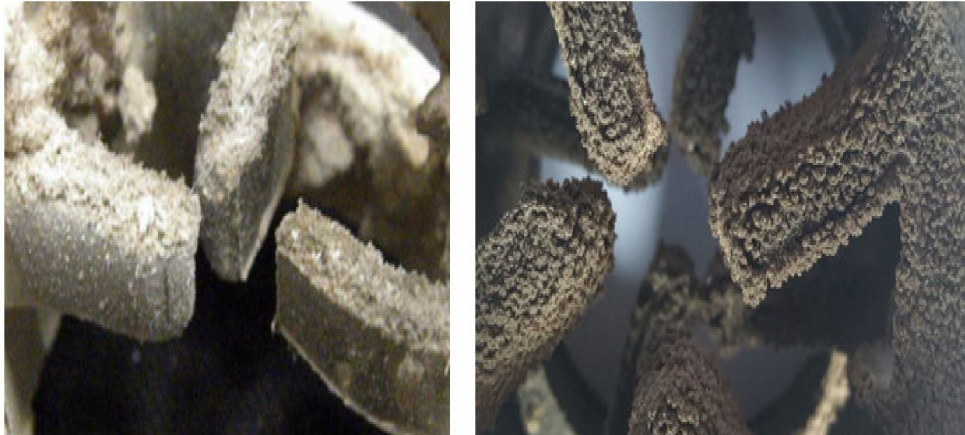
Figure 12. Particles agglomerated on the surface area of the packing technology